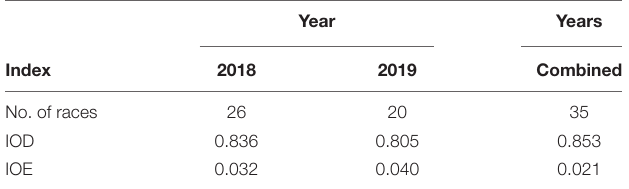
TABLE 5 | Simpson’s index of diversity (IOD) and evenness (IOE) for 254 Leptosphaeria maculans isolates collected from commercial canola fields in Manitoba in 2018 and